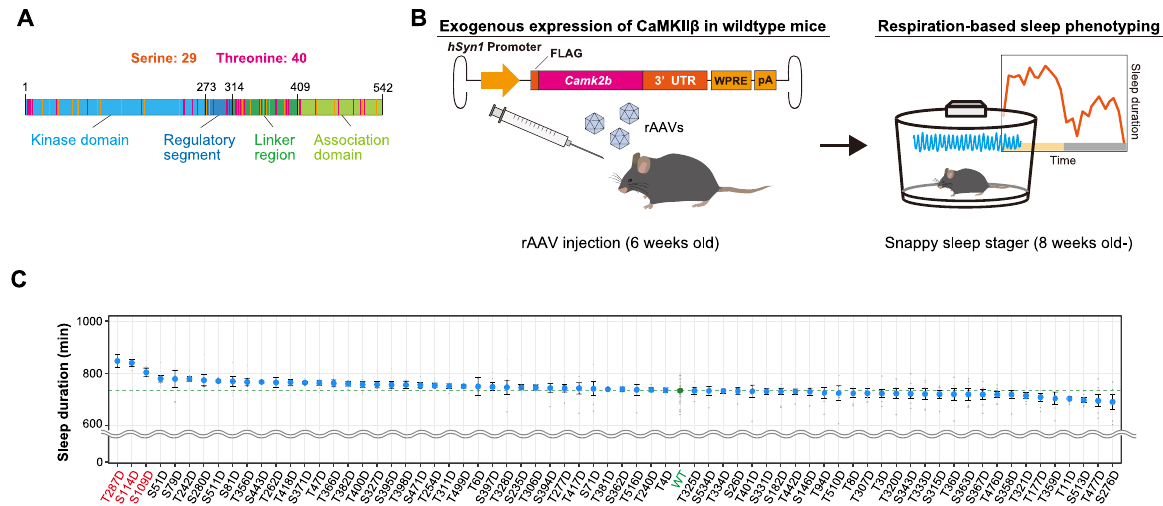
Fig 1. Phosphorylation of CaMKII β regulates sleep induction. (A) The 29 serine and 40 threonine residues throughout CaMKII β . Orange and magenta lines represent serine and threonine residues, respectively. Color-coded regions indicate the functional domains of CaMKII β . (B) Schematic diagram of AAV-based CaMKII β expression and respiration-based sleep phenotyping. (C) Daily sleep duration of mice expressing CaMKII β phosphomimetic mutants ( n = 6–10) in the presence of endogenous WT CaMKII β . The represented value is the average of SSS measurements over 6 days. The dashed green line represents the average sleep duration of WT CaMKII β -expressing mice (WT, n = 48). Residues